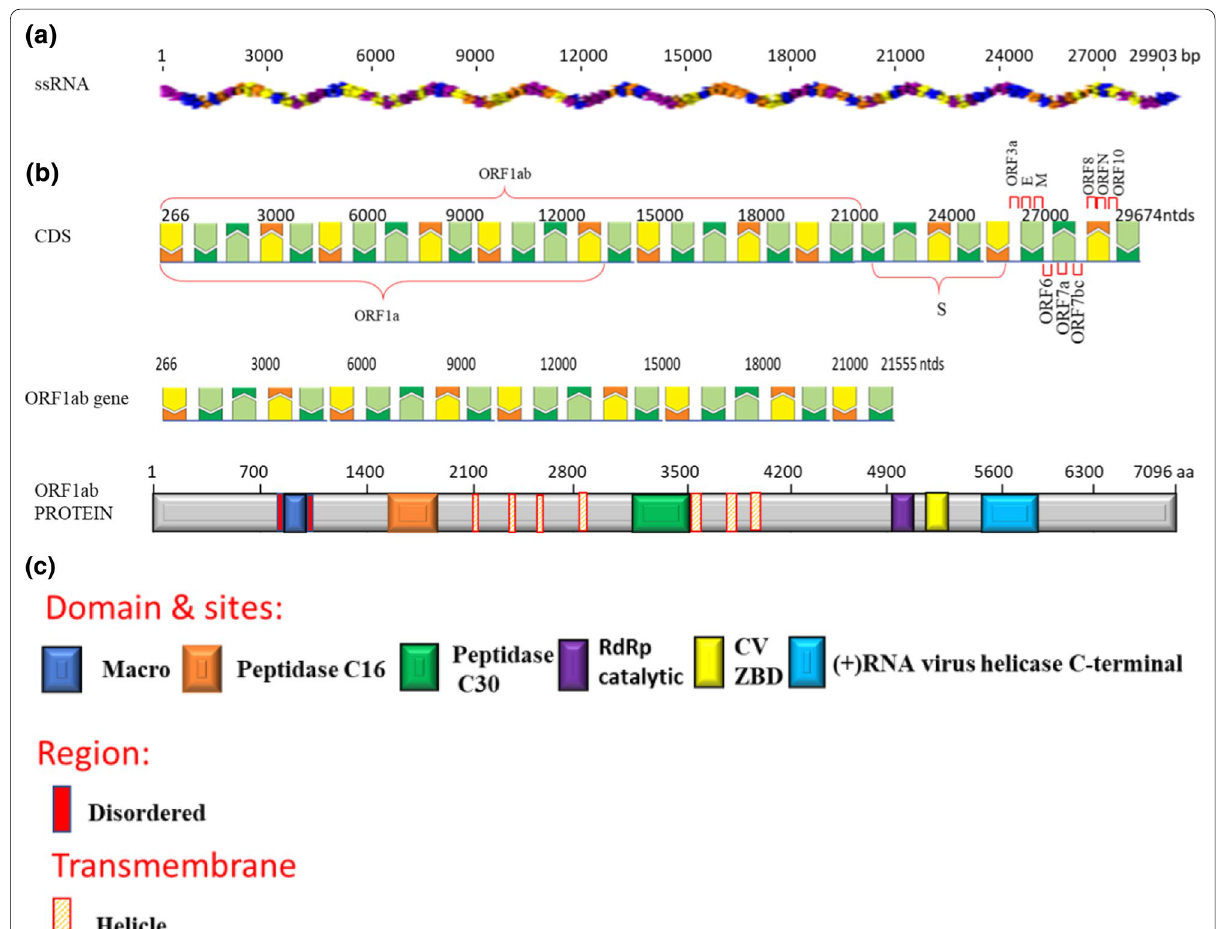
Fig. 4 a Genomic RNA of SARS-CoV-2 isolates Wuhan-1 (NC_045512). b Coding sequences of SARS-CoV-2. c ORF1ab polyprotein with Regions, Transmembrane and Domain sites of Macro, Peptidase C16, Peptidase C30, RdRp catalytic, CV ZBD and